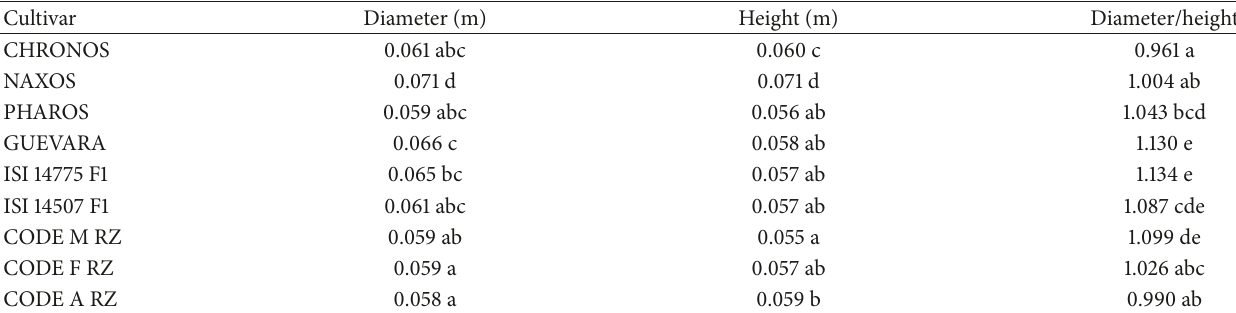
Table 5: Agronomic characteristics of sprouts from nine broccoli cultivars.